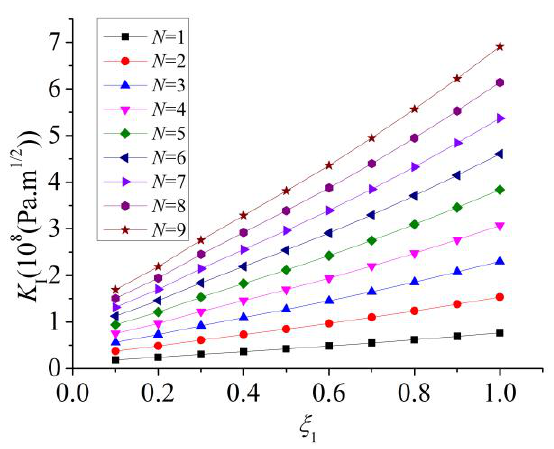
K  − curves for different loads. Figure 16. K − ξ I 1 curves for different loads. I 1